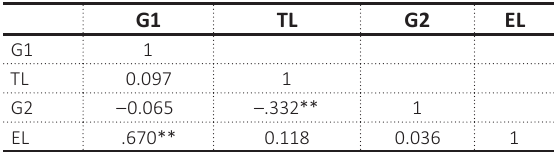
Table 2. Application of leadership behavior for SMEs growth